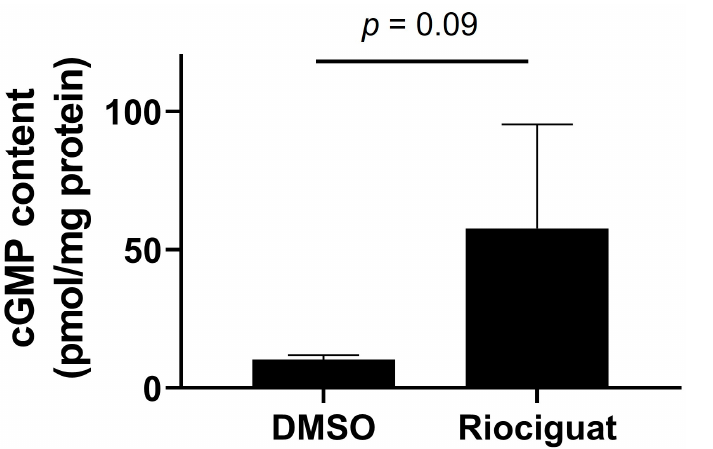
Figure 3. Effect of riociguat on production of cyclic guanosine monophosphate (cGMP) in an isolated endothelium-denuded canine pulmonary artery. After the vessels were treated with riociguat (100 nM, n = 4 rings) for 15 min, its total protein lysates were harvested. The cGMP levels were determined by ELISA. Result was expressed as means ± SD.